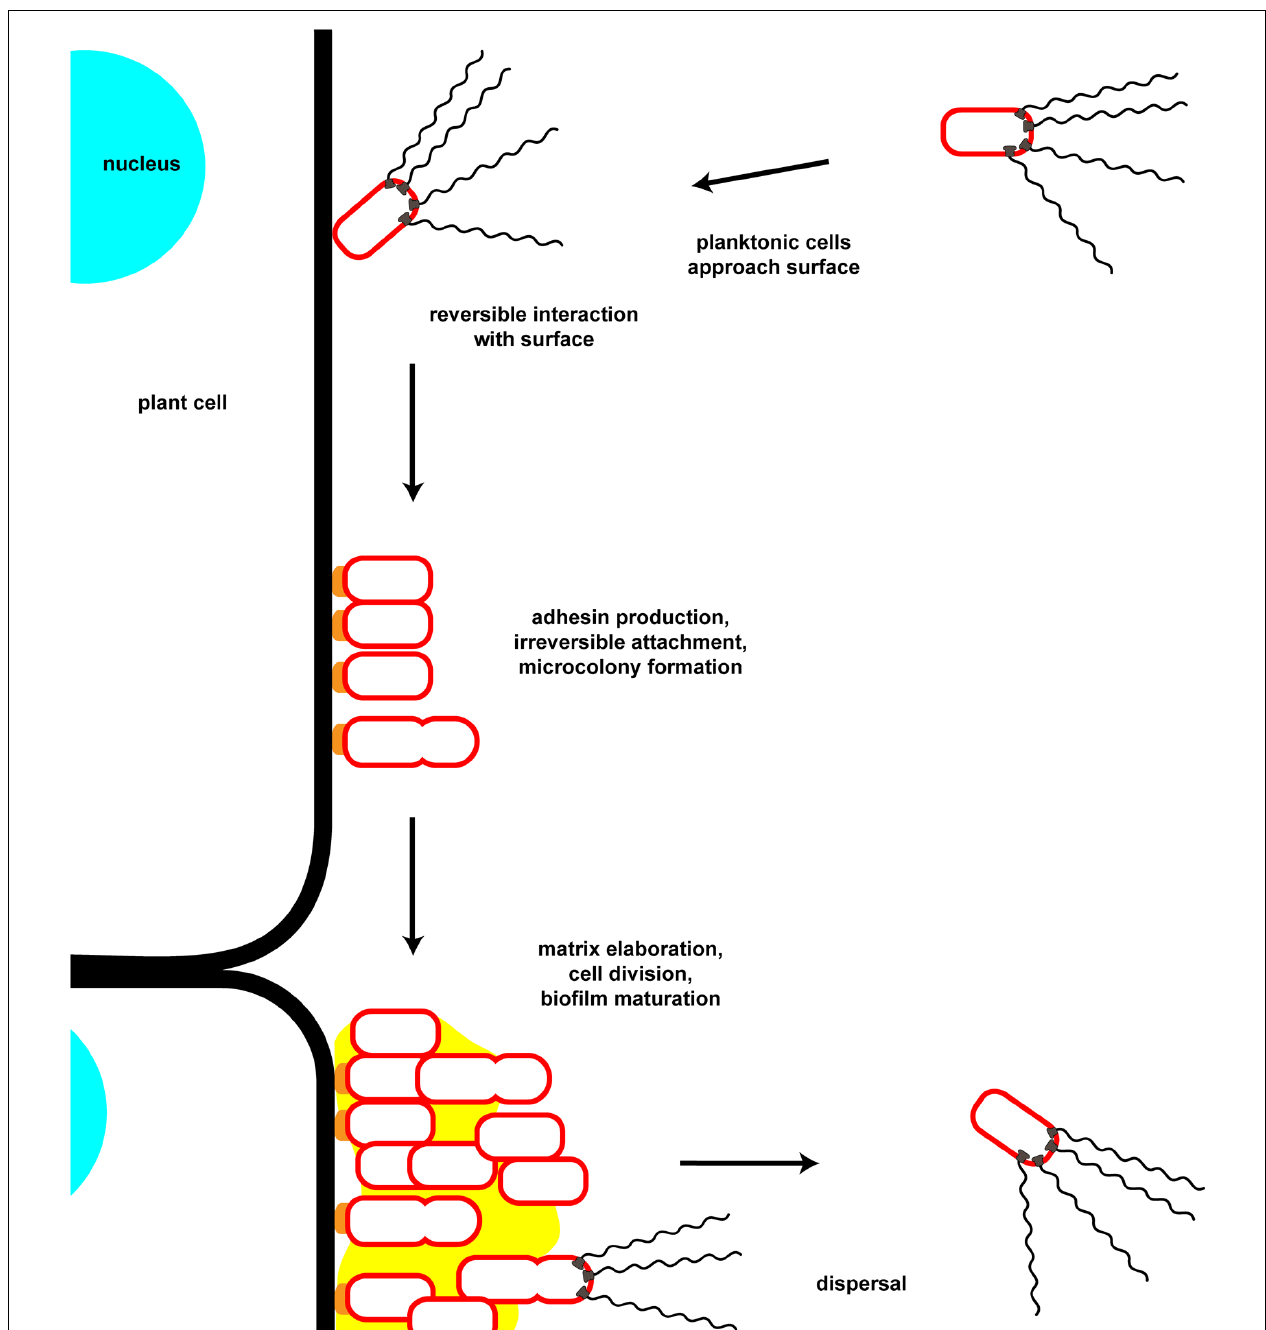
bacteria as well as aggregation of neighboring microcolonies. During and following this period cells secrete matrix components, including cellulose. As the biofilm matures cells may differentiate into various metabolic and reproductive states as the local environment within the biofilm changes. Dispersal from the biofilm may be initiated by an internal developmental cue or by an extracellular factor, as well as through release of motile daughter cells from attached mother cells. Note that in this cartoon only the outer membrane of the Gram-negative cell envelope is